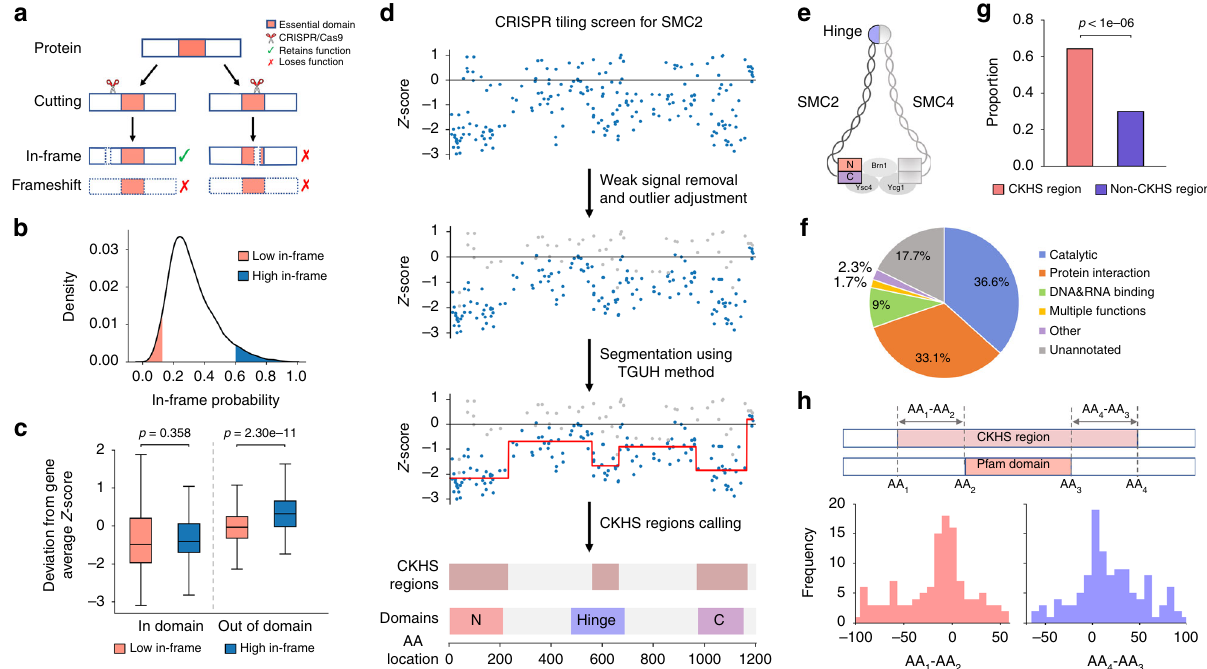
Fig. 1 Mapping CRISPR-knockout hyper-sensitive (CKHS) regions with ProTiler. a An in-frame indel model underlying the rationale of domain-associated CKHS regions. b Distribution of in-frame probability of the sgRNAs targeting essential proteins in Munoz data. The probabilities were predicted using inDelphi 11 . The top 5% and bottom 5% sgRNAs are de fi ned as high in-frame (blue) and low in-frame (red), respectively. c Box-plots comparing the dropout effects between high in-frame and low in-frame sgRNAs that target proteins containing drug target domains. The center line, bounds of box and whiskers represent the median, interquartile range and 1.5 times interquartile range, respectively. The p -values were computed using the Mann – Whitney test. d The work fl ow of ProTiler. The dot plots show the dropout effects, in Z-score 6 ( Y -axis), of sgRNAs targeting the gene coding for SMC2. A negative value of the Z-score corresponds to a dropout effect. Each dot represents an sgRNA mapped to the amino acid location ( X -axis). The grey dots and blue dots represent fi ltered and remaining sgRNAs, respectively. The red line shows the segmented protein regions and their dropout signal levels. e A structural model of condensin complex, in which SMC2 and SMC4 form a heterodimer via hinge domains, and their ATPase head domains (N and C) are associated with kleisin subunits to create a ring-like structure. f Categorization of CKHS regions based on the molecular functions of overlapped protein domains. g A bar chart showing the proportion of AAs in Pfam domains, for CKHS regions and non-CKHS regions respectively. The p -value was empirically computed by random simulation. h Distribution of distances between the borders of CKHS regions and domain boundaries as de fi ned in the Pfam